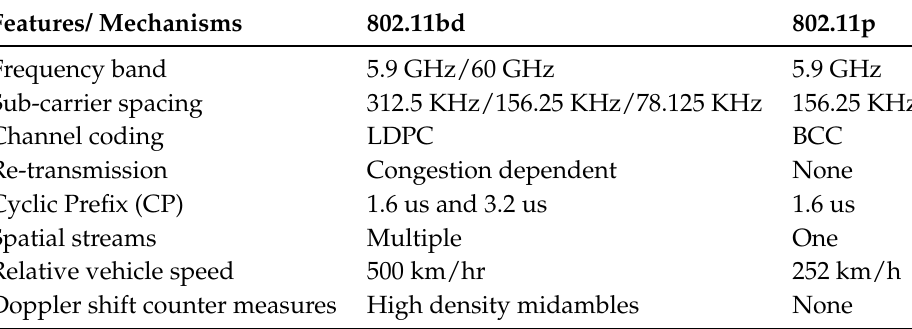
Table 3. Feature comparison between 802.11bd and 802.11p.